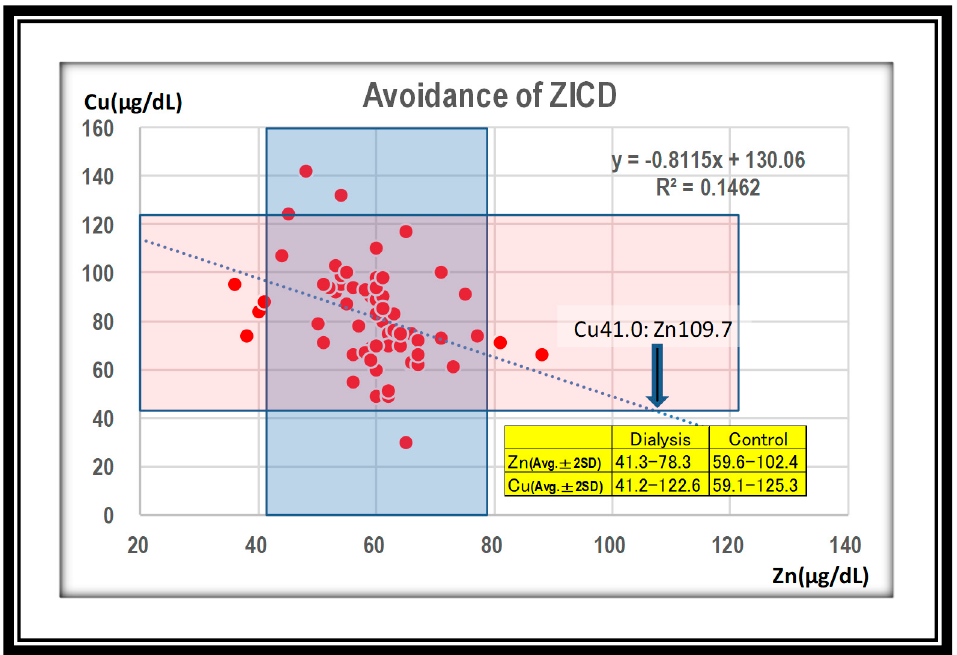
Figure 5. In the dialysis group, a zinc value over 109.7 μ g/dL could cause copper deficiency. Squares show average. ± 2SD of zinc and copper in the hemodialysis group.